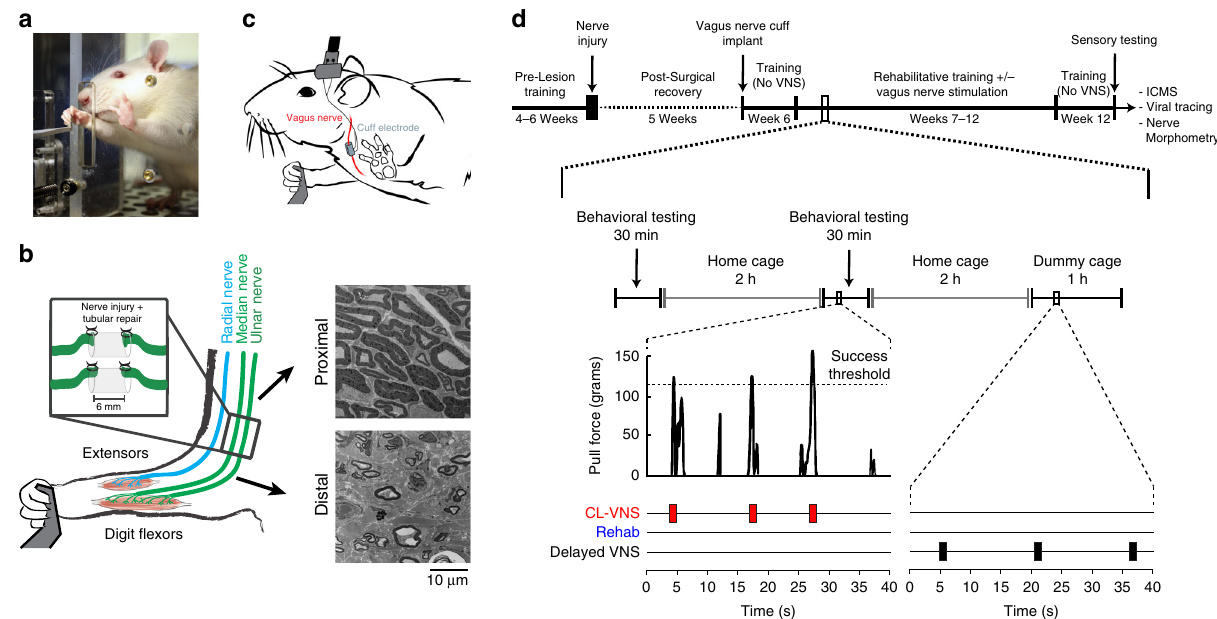
Fig. 1 Median and ulnar nerve injury and delivery of vagus nerve stimulation during rehabilitation. a A rat performing the volitional forelimb isometric pull task. b Schematic of the nerve injury. The median and ulnar nerves in the trained forelimb, innervating the digit fl exor muscles required for grasping, were individually transected. The nerve stumps were then sutured into a guide conduit leaving a 6 mm gap between stumps. Reinnervation takes place, but the procedure results in chronic de fi cits in nerve architecture distal to the injury site. The radial nerve innervating the wrist and digit extensors of the forelimb was spared. Scale bar indicates 10 µ m. c Illustration of the VNS device. A cuff electrode was placed on the left cervical vagus nerve in the neck with subcutaneous leads connected to a head-mount. d Timeline of rehabilitative training after nerve injury. Rehabilitation began 6 weeks after nerve injury, and rats received either closed-loop VNS paired with forelimb movement during rehabilitation (CL-VNS), equivalent training without VNS (Rehab), or a matched amount of VNS delivered after equivalent daily training sessions (Delayed